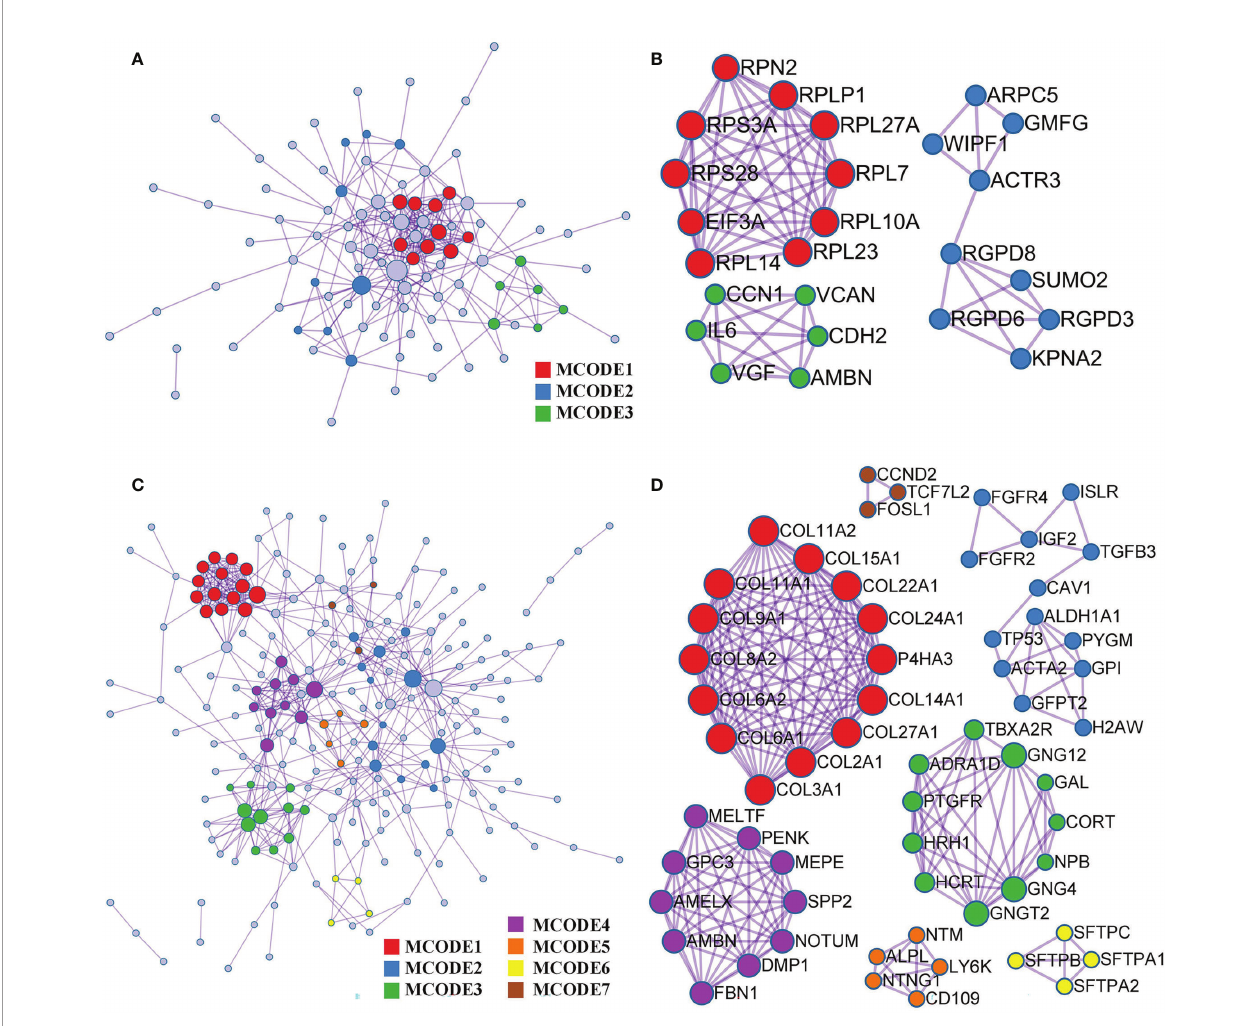
FIGURE 5 | PPI and hub gene clusters network construction. (A) A PPI network from GSE42352 data set. (B) Three hub gene clusters obtained by the MCODE clustering algorithm from GSE42352 data set. (C) A PPI network from TARGET data set. (D) Seven hub gene clusters obtained by the MCODE clustering algorithm from TARGET data